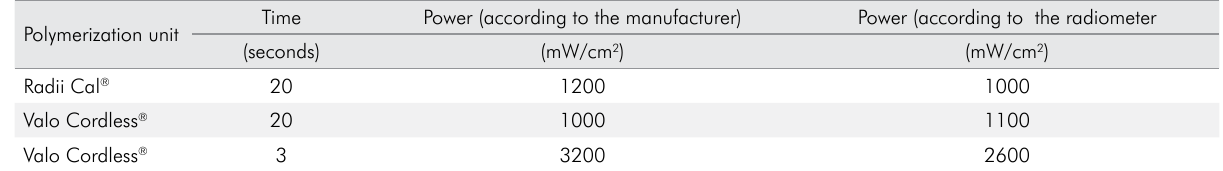
Table 7. Power of the polymerization units according to the manufacturer and the calibration in the radiometer. Polymerization unit